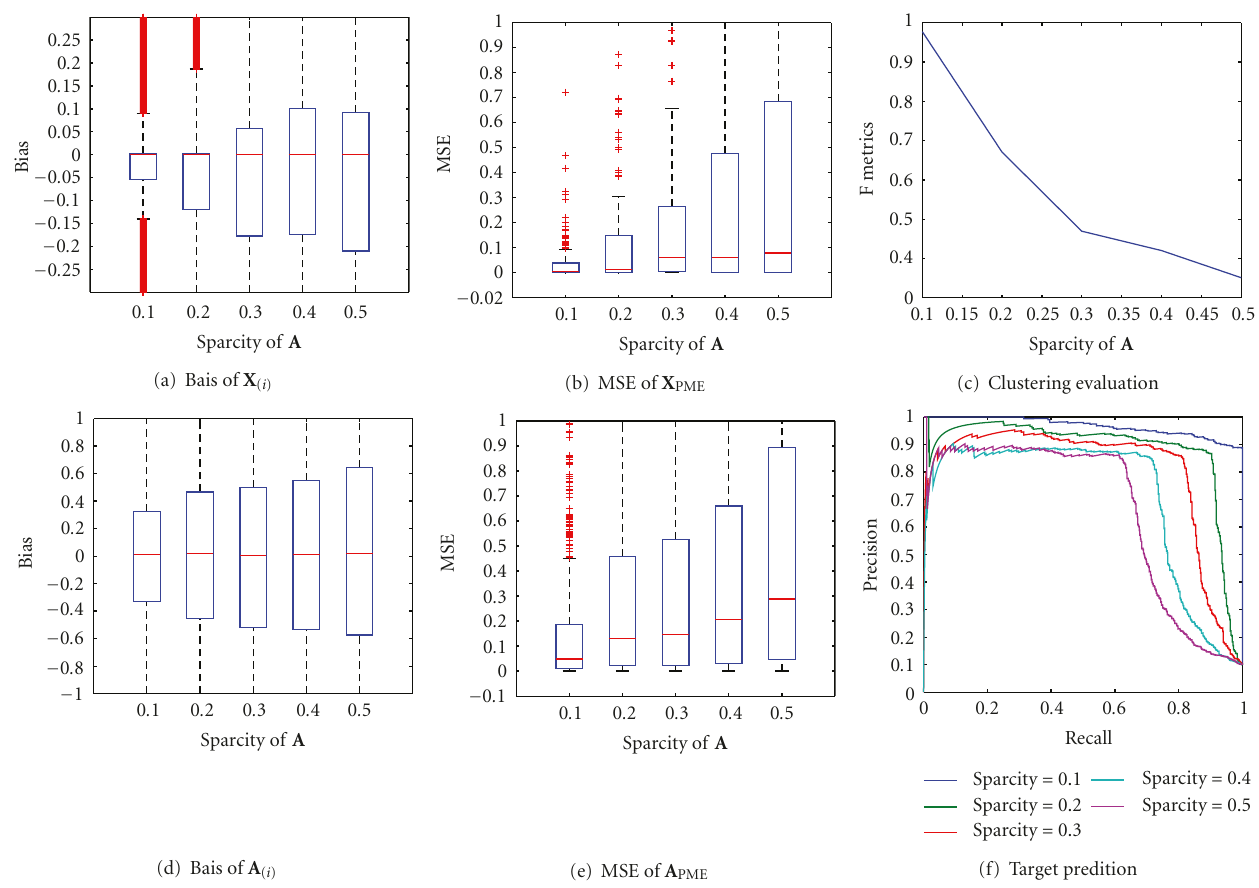
Figure 7: Performance of BSCRFA when the sparcity of loading matrix is di ff erent.